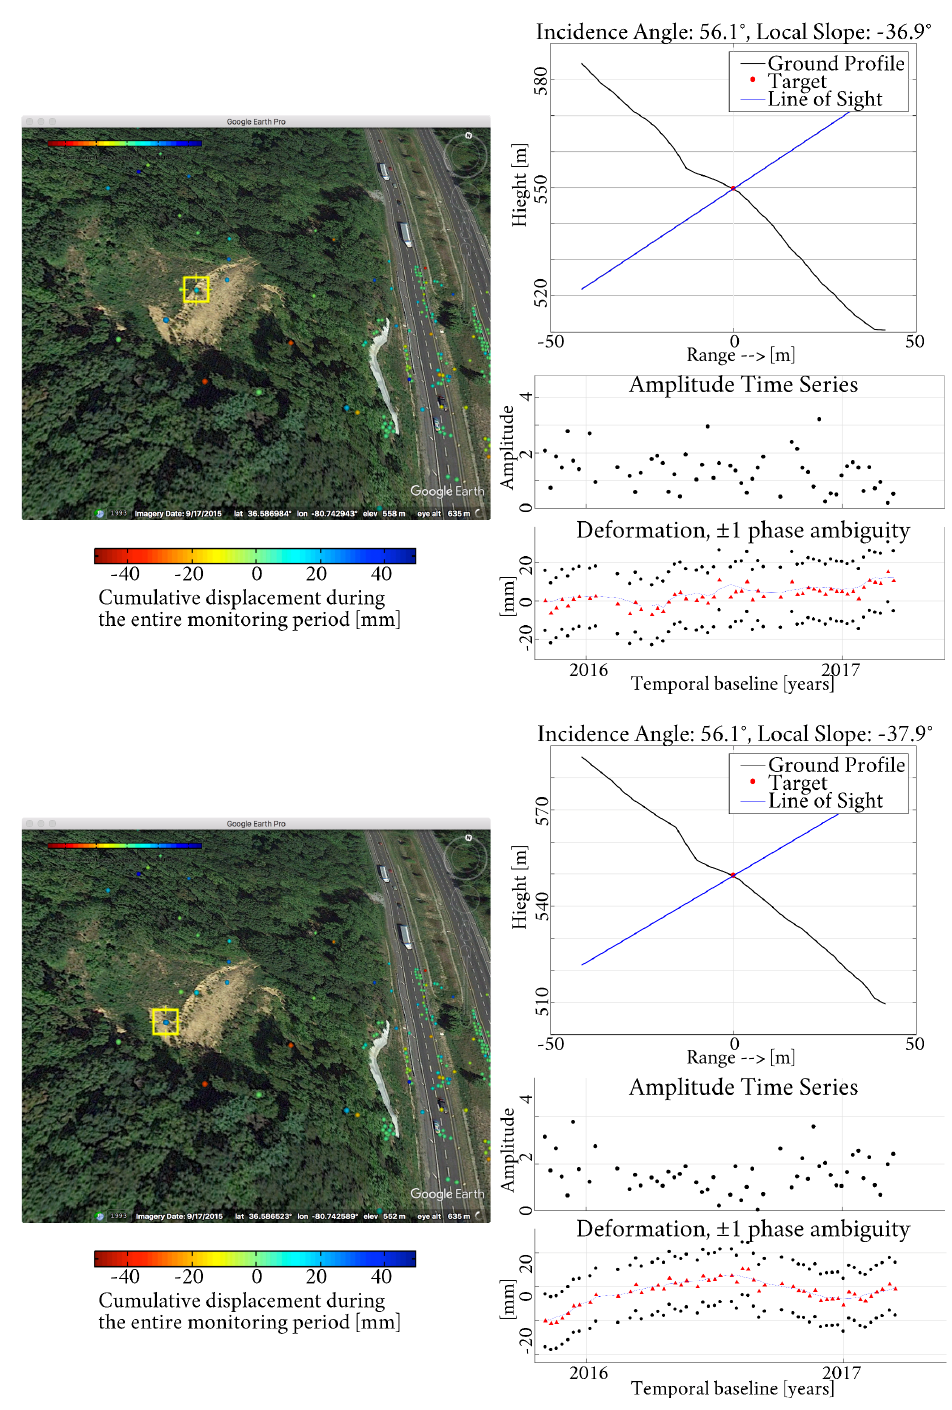
Figure 16. The settlement for two selected points located on the soil slope. The processing was done using a window size larger than the default in the non-parametric model. The color of the points is the cumulative displacement of the monitoring period, ranging from − 50 to 50